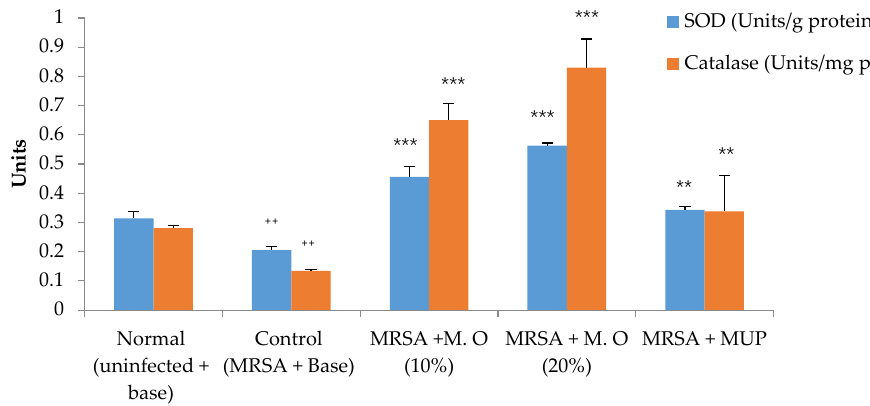
Figure 4. Effect on antioxidant enzymes in MRSA-infected diabetic animals. All values are mean ± SEM, n = 6, ++ p < 0.01when compared to normal (uninfected). ** p < 0.01, *** p < 0.001 when compared to control (infected). M.O = M. oleifera leaf extract formulation, MUP = mupirocin (2% w / w ).